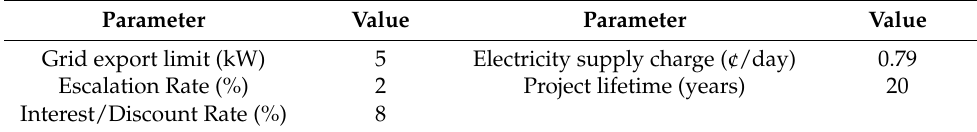
Table 2. Parameters associated with the optimal sizing project for the case study.